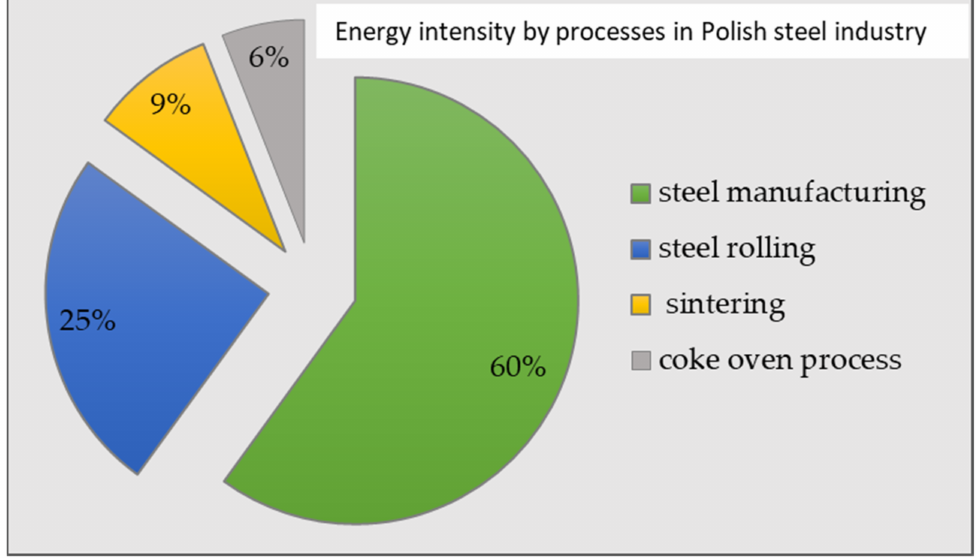
Figure 2. Energy intensity in Polish steel industry by process. Source: own elaboration based on Polish Steel Technology Platform (in Polish: PPTS)